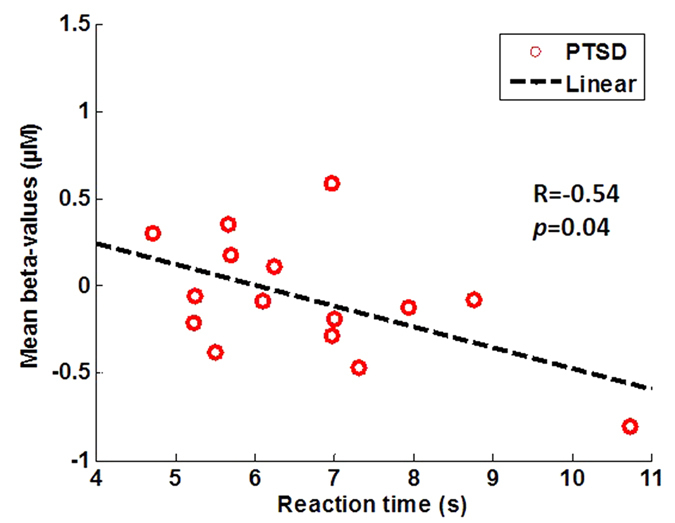
Correlation between individual task reaction times and ROI-averaged HbO2 responses (i.e., β-values) from the ROI (i.e., channels 28, 29 and 31) in the left DLPFC under Stroop2 task, taken from PTSD subjects.